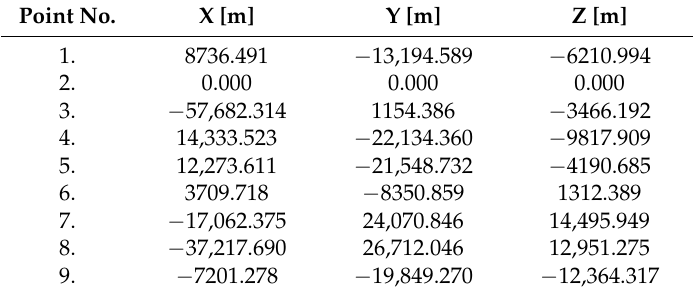
Table 5. Points from secondary system—Table 3—translated to the centroid—point no. 2. Point No. X [m] Y